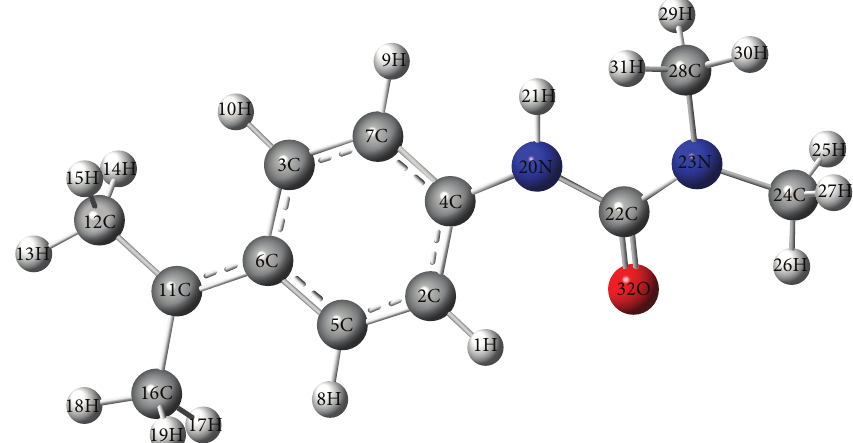
Figure 1: Optimized structure of isoproturon at the MP2/6-311++G(2d,2p) level of theory. Bond distances: 2C-4C = 1.39, 2C-5C = 1.37, 3C- 6C = 1.40, 3C-7C = 1.36, 4C-7C = 1.39, 5C-6C = 1.40, 6C-11C = 1.43, 11C-12C = 1.50, 11C-16C = 1.50, 4C-20N = 1.40, 20N-22C = 1.39, 22C-23N = 1.37, 22C-32O = 1.24, 23N-28C = 1.46, 23N-24C = 1.46, N-H = 1.00, C-H = 1.09 in methyl groups, and C-H = 1.08 in the ring. Dihedral angle